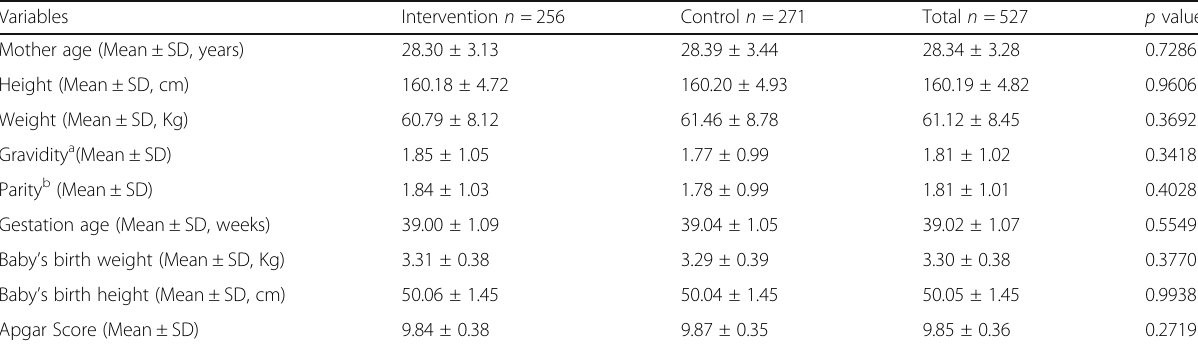
Table 1 Baseline main demographic and clinic characteristics of subjects enrolled in the randomized controlled trial for Zengru Gao Variables